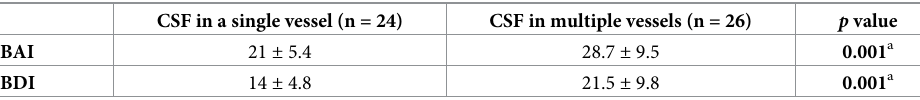
Table 5. BAI & BDI scores in single versus multivessel coronary slow